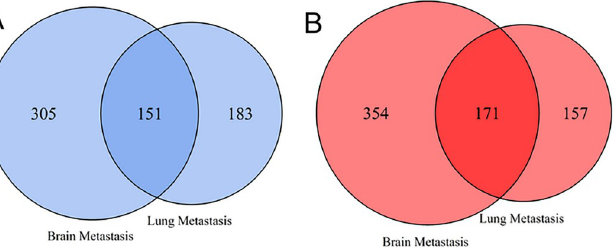
Fig 2. Venn diagram that shows the overlap of differentially expressed genes (DEGs) between the brain and lung metastases from breast cancer: (A) A total of 456 and 334 down-regulated DEGs were identified for brain and lung metastases, respectively, among which there were 151 common DEGs. (B) A total of 525 and 328 up-regulated DEGs were explored for brain and lung metastases, respectively, among which 171 DEGs were shared.